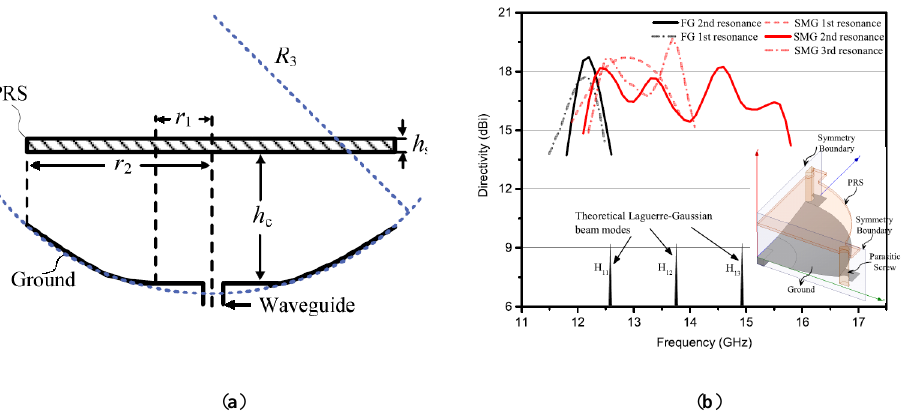
Figure 7. ( a ) RCA with a modified ground plane; ( b ) Directivity [75].